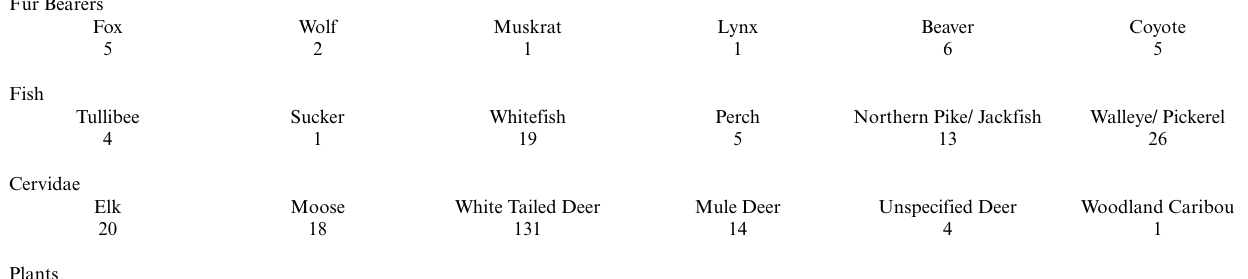
Table 2. Species encountered by Athabasca Landing Métis Community harvesters, documented in photo-map database (2019–2022). Fur Bearers Fox